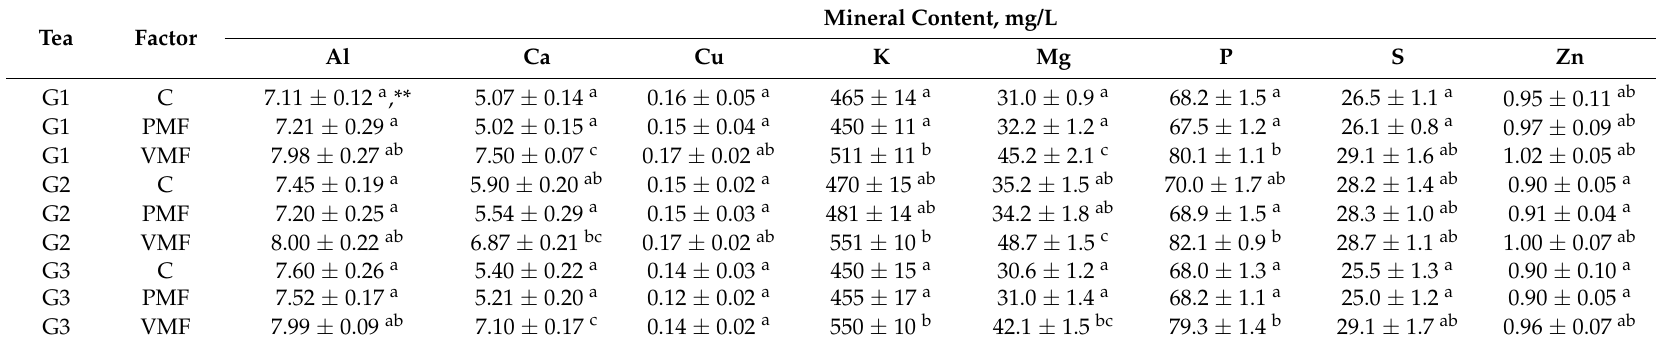
Table 2. Analytical findings showing the content of selected chemical elements in green tea infusions extracted with the use of a magnetic field under control conditions.